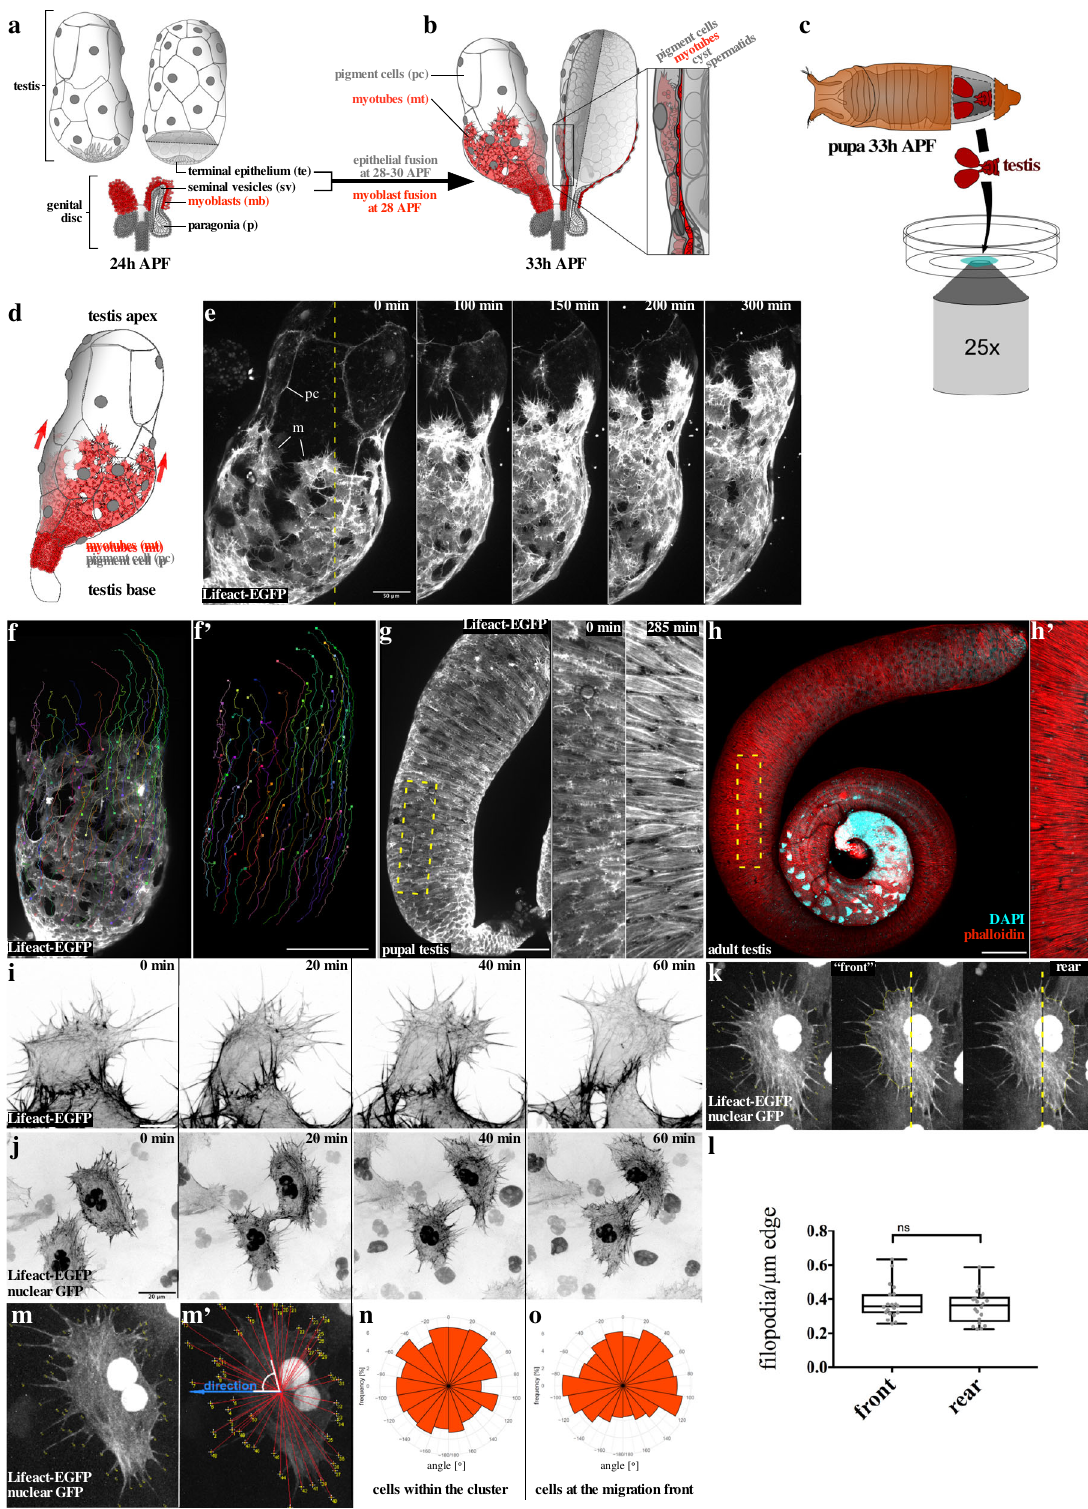
Myotube migration depends on formin-dependent fi lopodial membrane protrusions . Strikingly, migrating myotubes largely lacked lamellipodial protrusions, but instead formed numerous fi lopodia-like protrusions (from here on referred to as fi lopodia; Fig. 1i; Supplementary Movie M3). Expression of LifeAct-EGFP together with a nuclear targeted EGFP transgene in myotubes in a mosaic-like fashion further showed that myotubes also formed